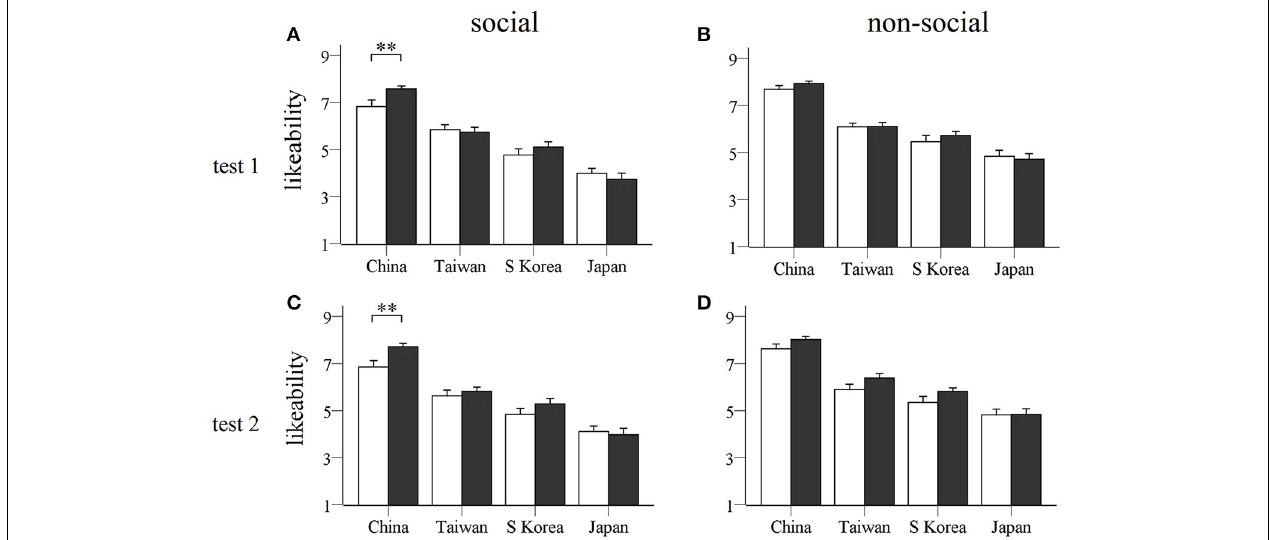
FIGURE 2 | Likeability ratings for each country. Histograms show mean ± s.e.m. likeability ratings of social (A,C) and non-social (B,D) stimulus pictures for four different countries given by OXT (filled bars) and PLC